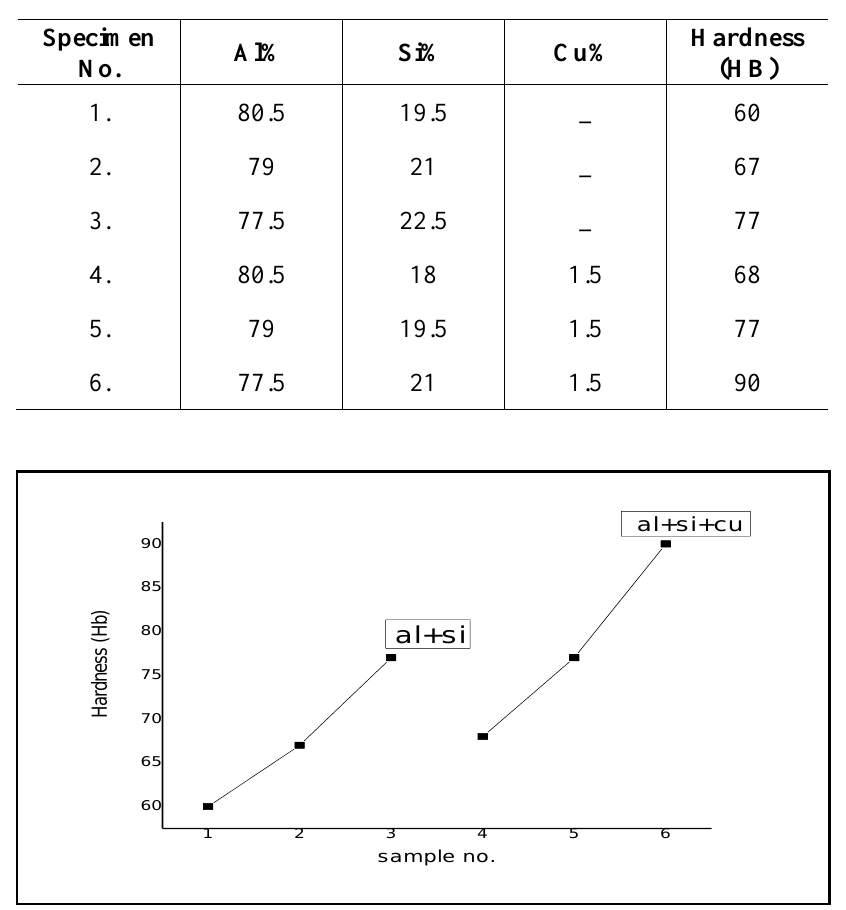
Table 3: Hardness test outcome.